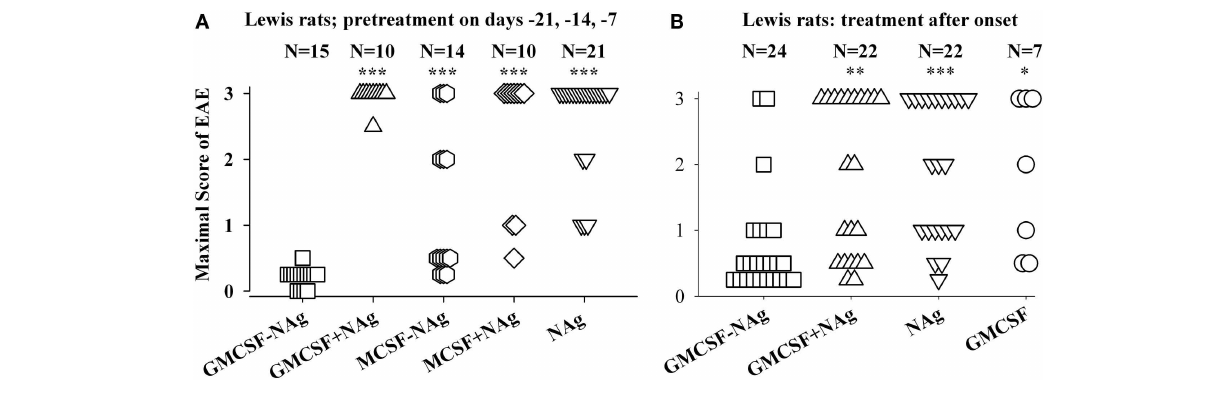
FIGURE 3 |The rat GMCSF-MBP vaccine was an effective tolerogen in the Lewis rat model of EAE. EAE was elicited in Lewis rats by injection of NAg in CFA on day 0. Designated cytokine-NAg proteins or control proteins ( x -axis) were given as pre-treatments on days-21, -14, and -7 (A) or alternatively were given as treatments after the onset of paralytic EAE (B) as described in (Blanchfield and Mannie, 2010).Vaccines were administered subcutaneously in saline. Maximal disease scores were